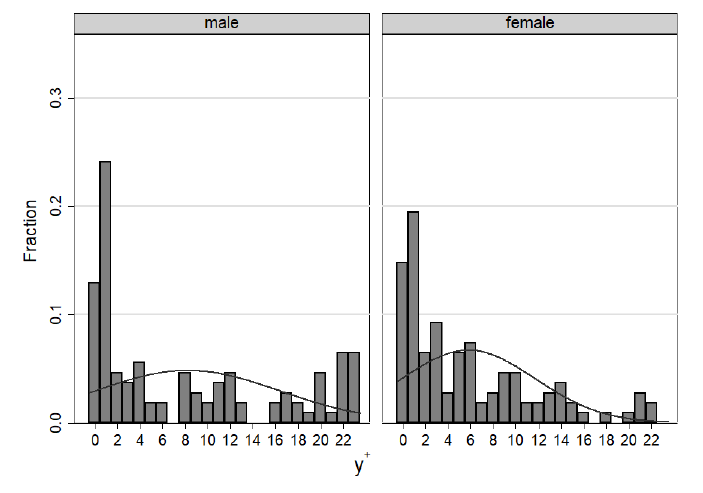
Figure 7. Distribution of average upward adjusted offer y + by